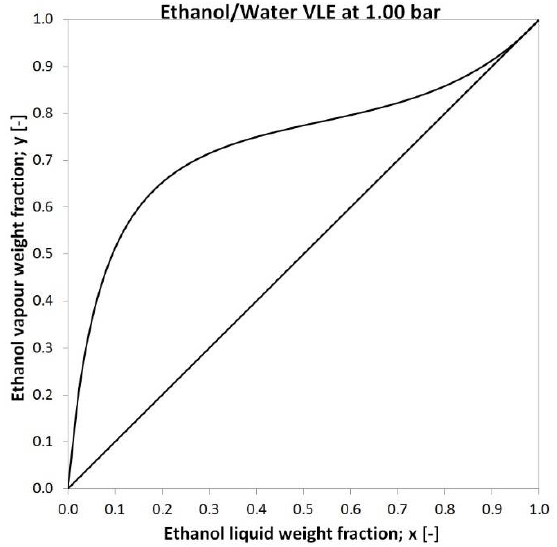
Figure 1. Ethanol-water mixture vapour-liquid equilibrium diagram at 1 bar [67].